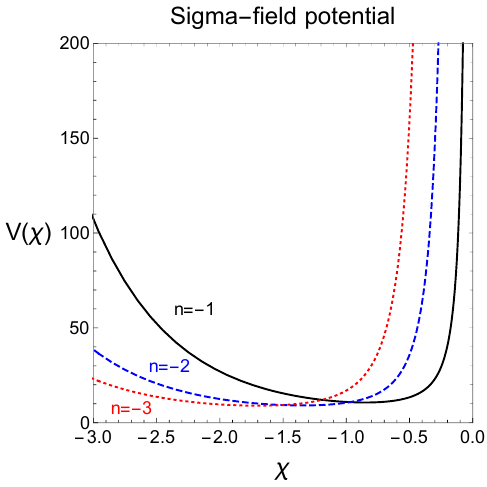
Figure 1 . The sigma field potential for n = − 1 , − 2 , − 3 in black solid, blue dashed, and red dotted lines,